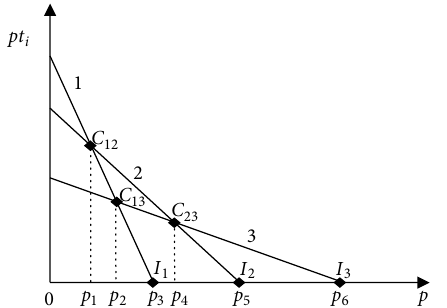
Figure 2: Order price with respect to one decision variable.